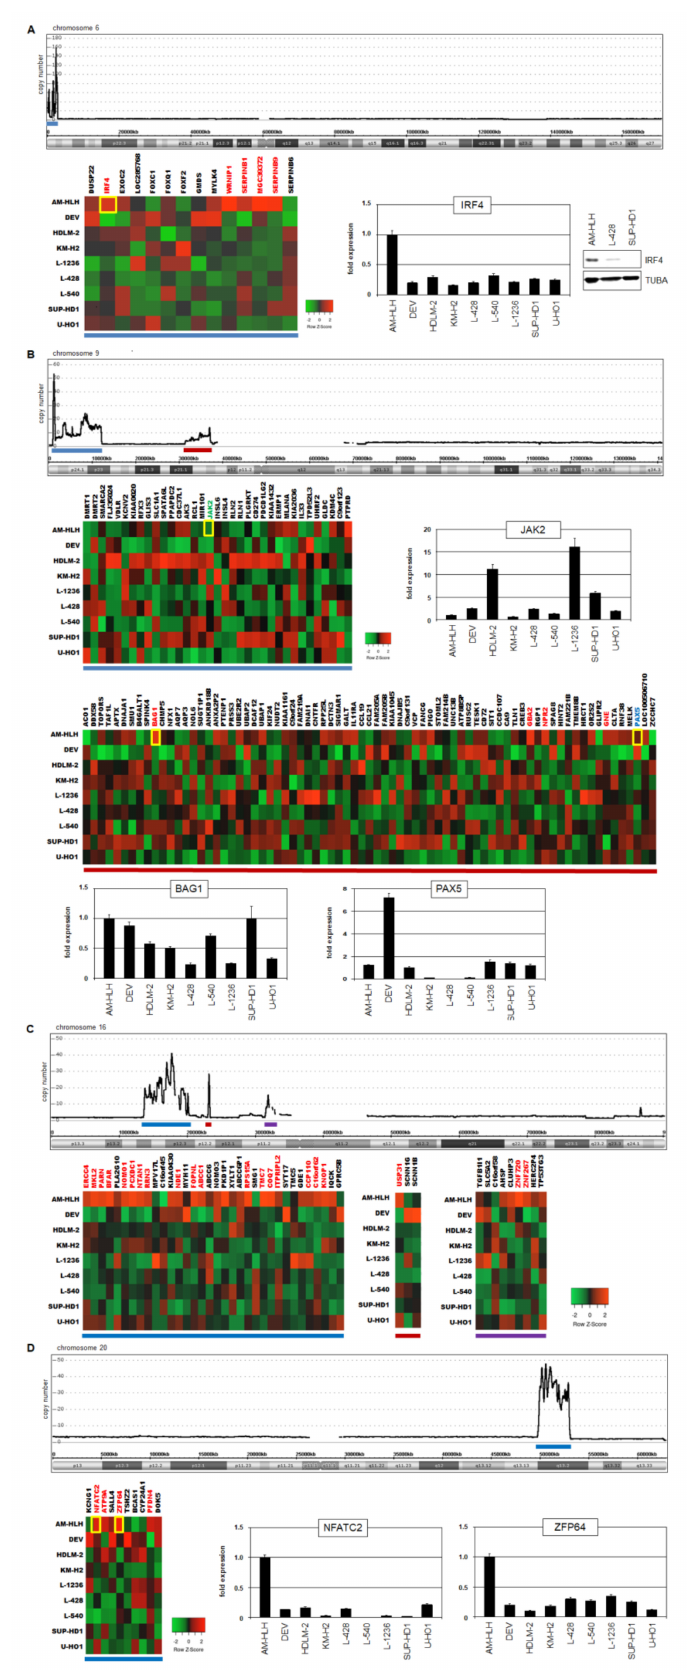
Figure 3. Genomic amplifications in AM-HLH and their consequences for gene activities. ( A )